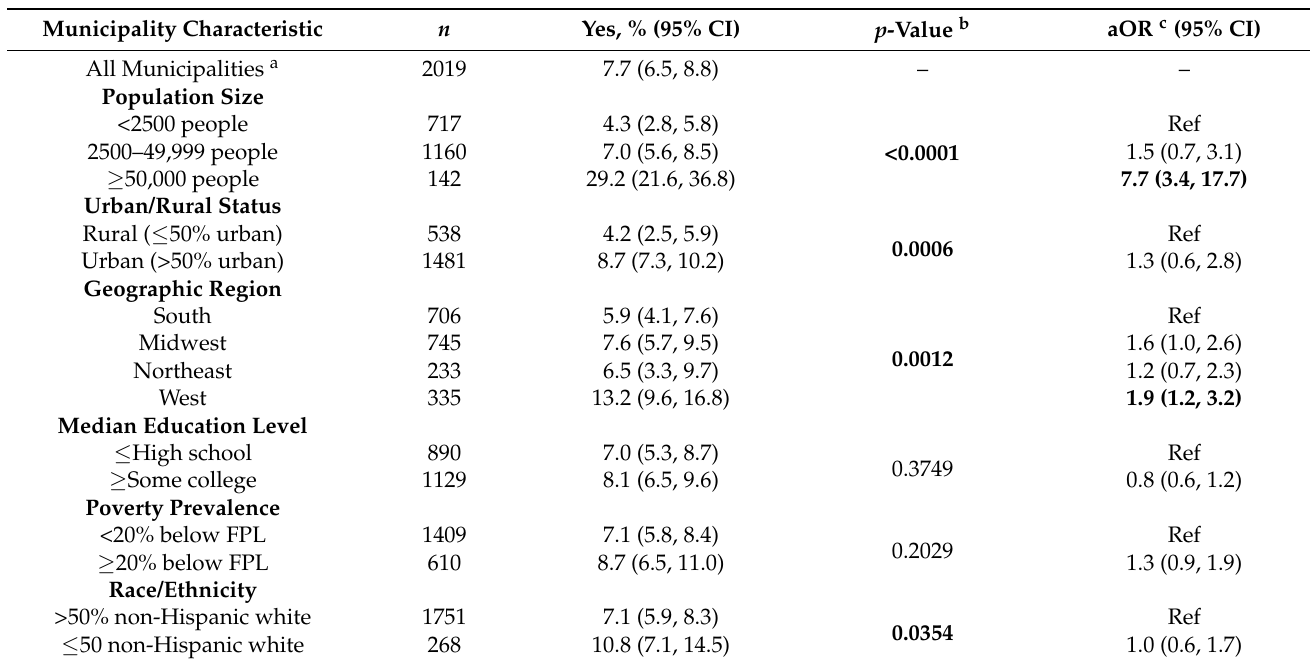
Table 2. Prevalence, 95% confidence intervals, and adjusted odds of having a local or regional food policy council (FPC), food security coalition, or similar entity among US municipalities, National Survey of Community-Based Policy and Environmental Supports for Healthy Eating and Active Living, United States, 2014.